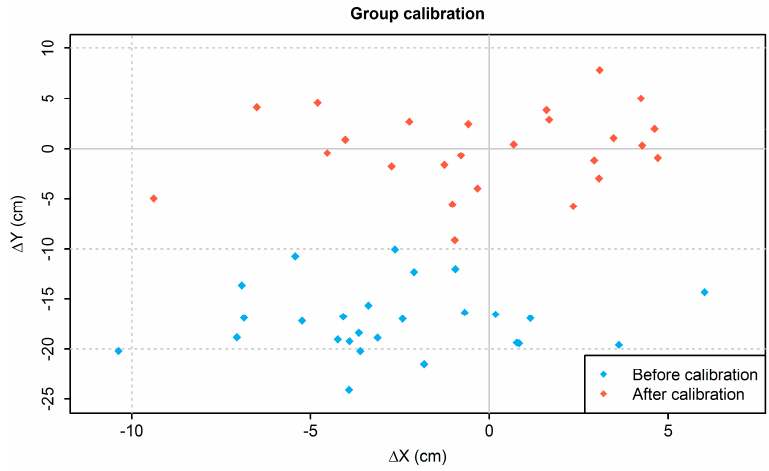
Figure 7. Comparison between single (top) and group calibration (below) of the HUMAC Balance System, both before and after calibration.